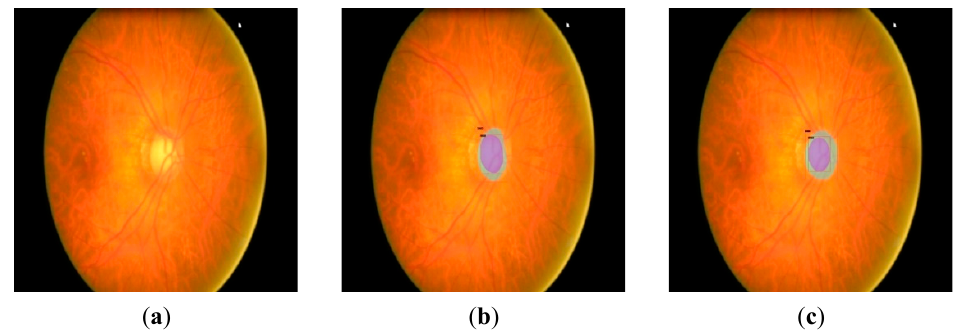
Figure 12. Segmentation on extern dataset with Cascade Mask-RCNN model. Original image from ORIGA-DB ( a ). Segmentation result from trained model with Refuge dataset ( b ). Segmentation result from trained model with G1020 dataset ( c ).